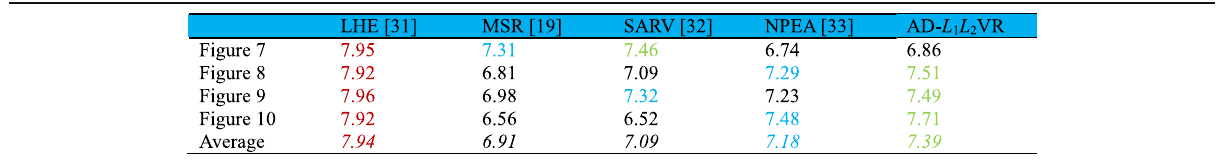
Table 2 Discrete entropy of compared methods